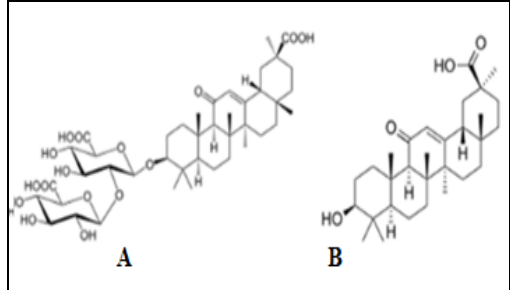
Figure 8. Chemical structure of A. glycyrrhizin and B. glycyrrhetinic acid (80)